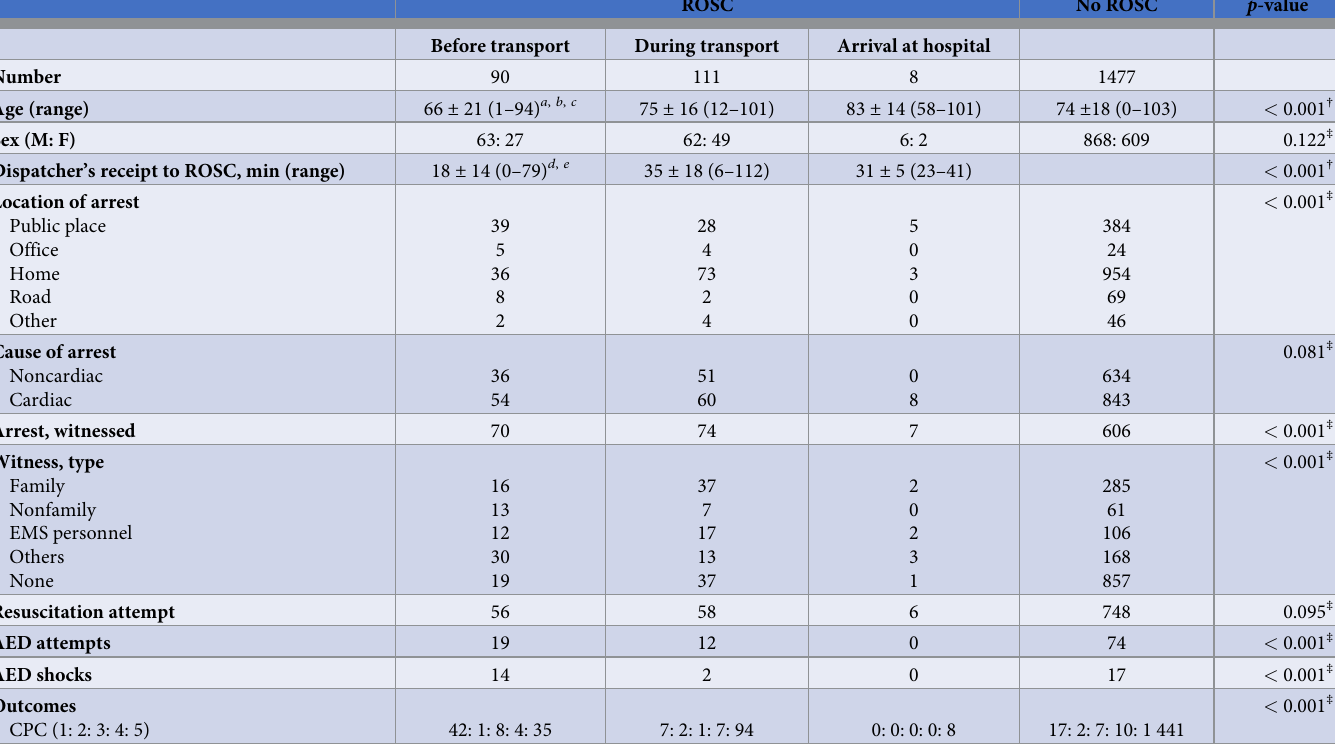
Table 2. Background of those who returned circulation spontaneously after out-of-hospital cardiac arrest. ROSC No ROSC p -value Before transport During transport Arrival at hospital